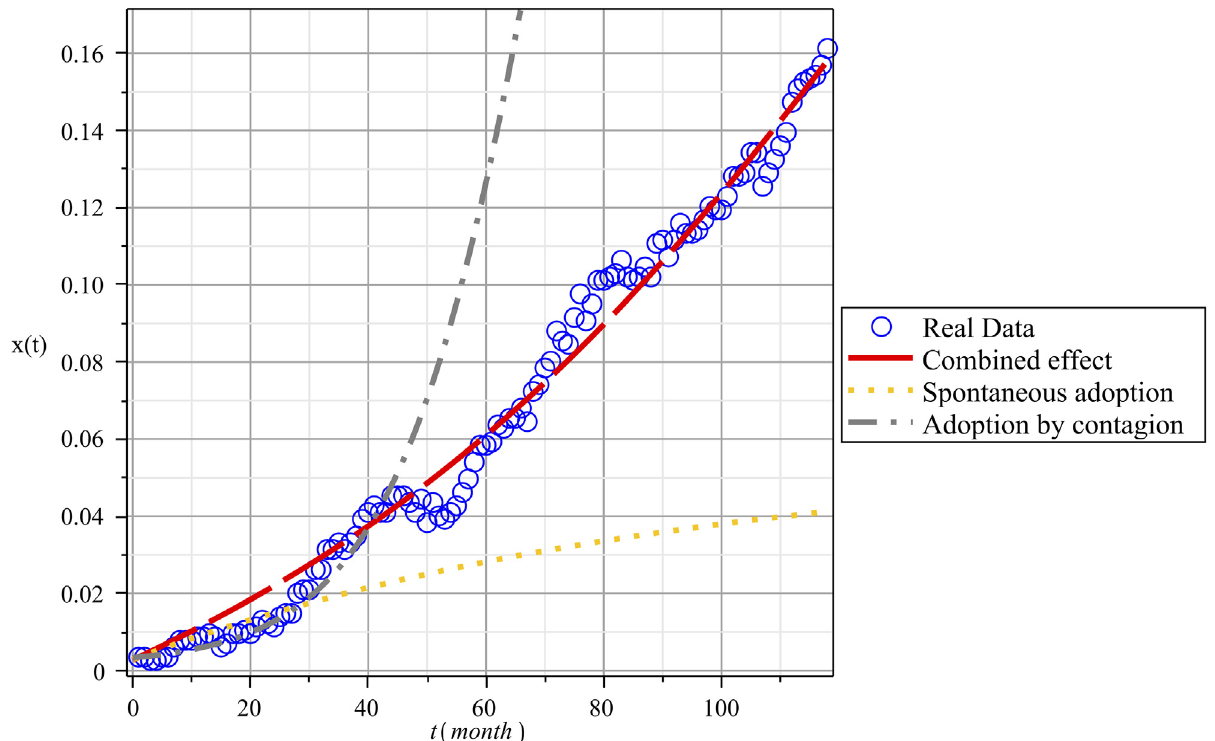
Fig 6. Fitting the Theoretical Solutions Provided by Model 2 and Adoption Data over Time. The gray curve represents the fit for the pure contagion case: W = 0, β = 0.0045, γ = 0.01, with a residual mean square SD = 0.2. The orange curve is the fit for pure non-social influences: W = 0.0006, β = 0, γ = 0.01, SD = 0.054622. The red curve is the fit for the combined effect W = 0.0007, β = 0.0017, γ = 0.01, SD =